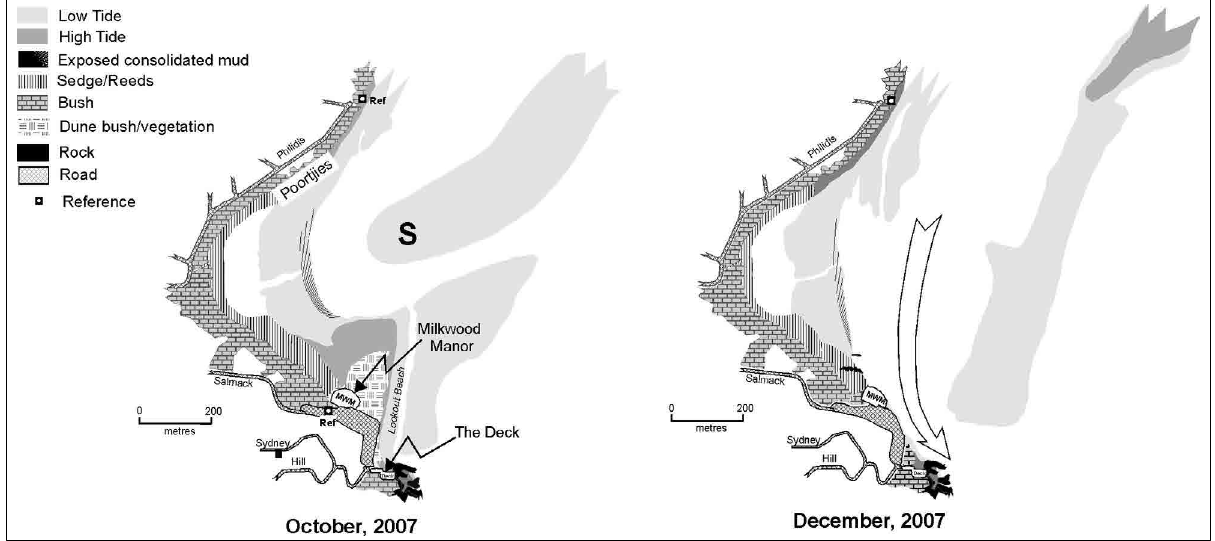
Figure 6: Sediment structure maps in the Keurbooms Estuary on the given dates. The legend gives the structures depicted, while the October 2007 map identifies sites mentioned in the text. The arrow depicts the main floodwater flow.